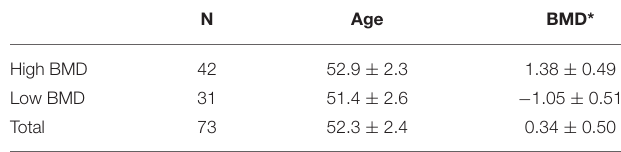
TABLE 1 | Demographic characteristics of the patient